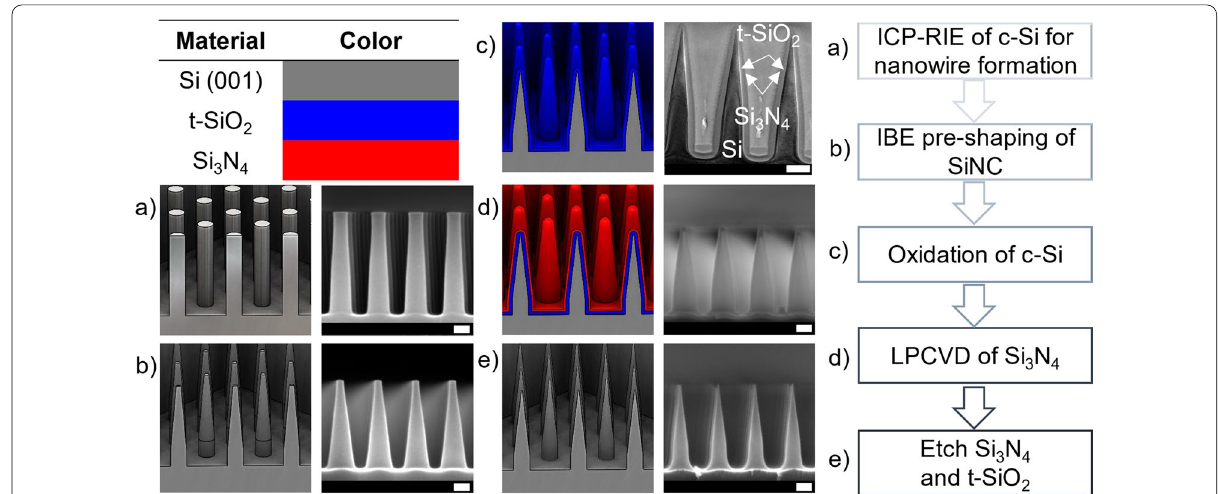
Fig. 1 Cross-sectional schematic representation and SEM and TEM images showing the fabrication process that converts SiNWs into SiNCs. The scale bars represent 100 nm. Additionally, a flowchart is presented showing the sequential fabrication